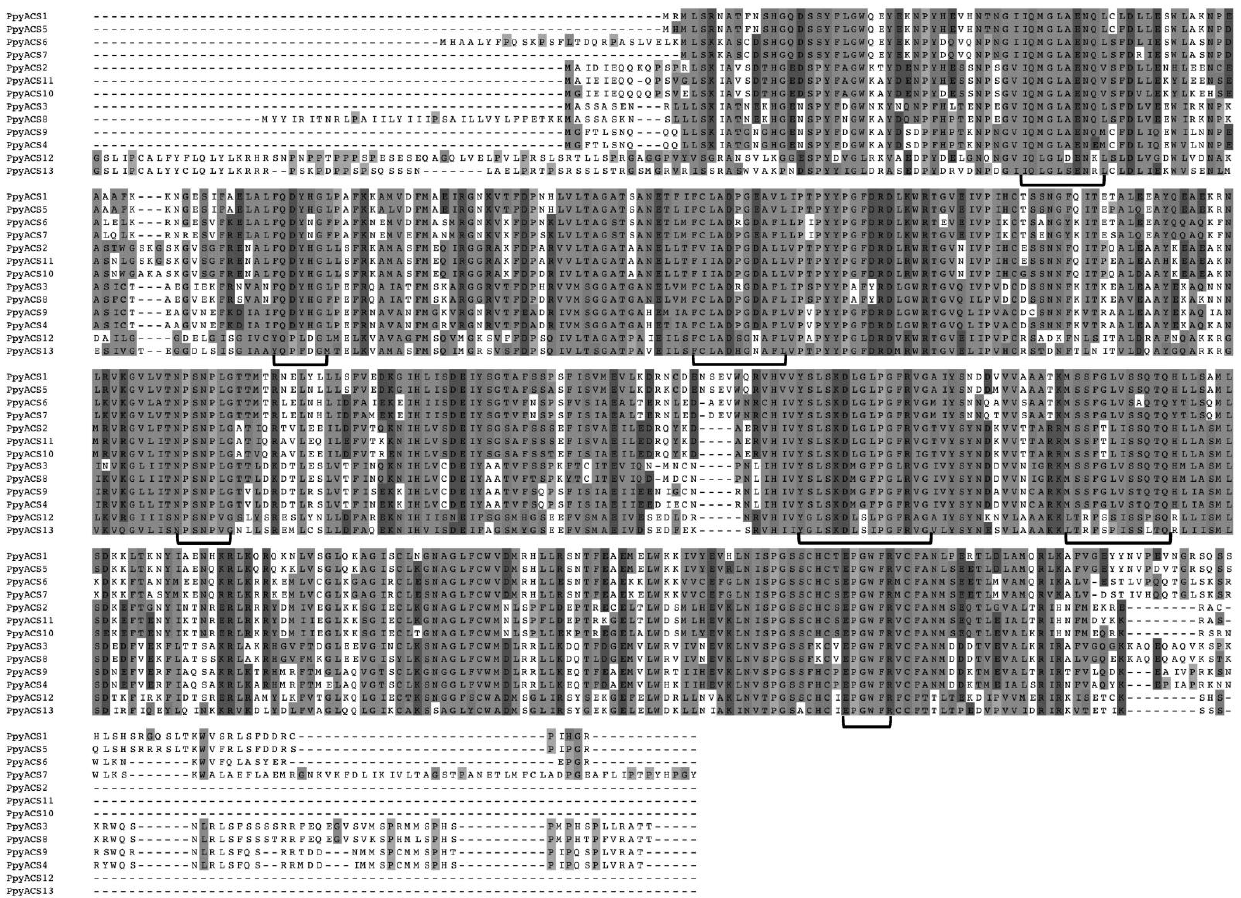
Figure 1. Amino acid sequence alignment of the PpyACSs. The seven conserved domains of the ACS isozymes are marked as red boxes. The seven highly conserved regions among all ACC synthases are underlined. Table 1. Genetic bioinformation of all identified ACS genes in Pyrus pyrifolia .